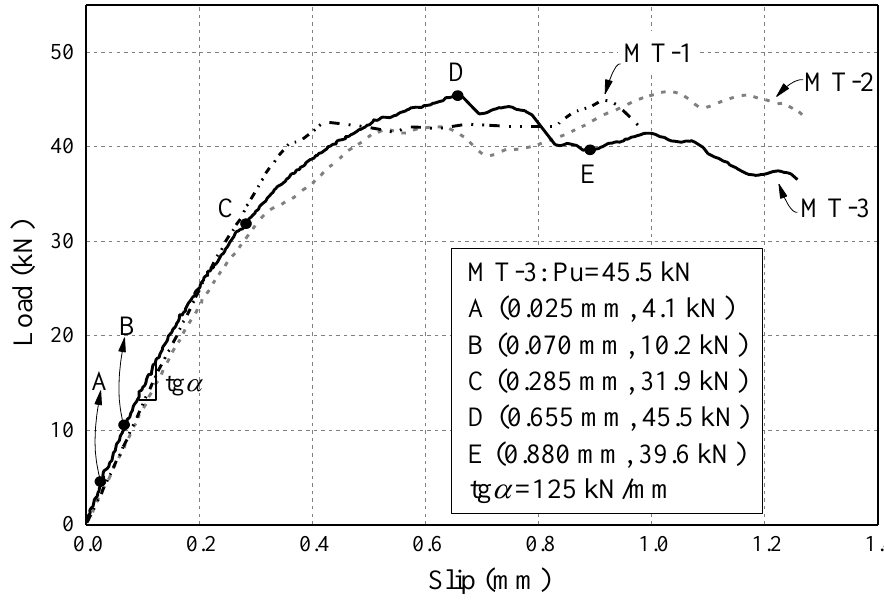
Figure 6. Load–slip relationship of the monotonic pull-out tests.